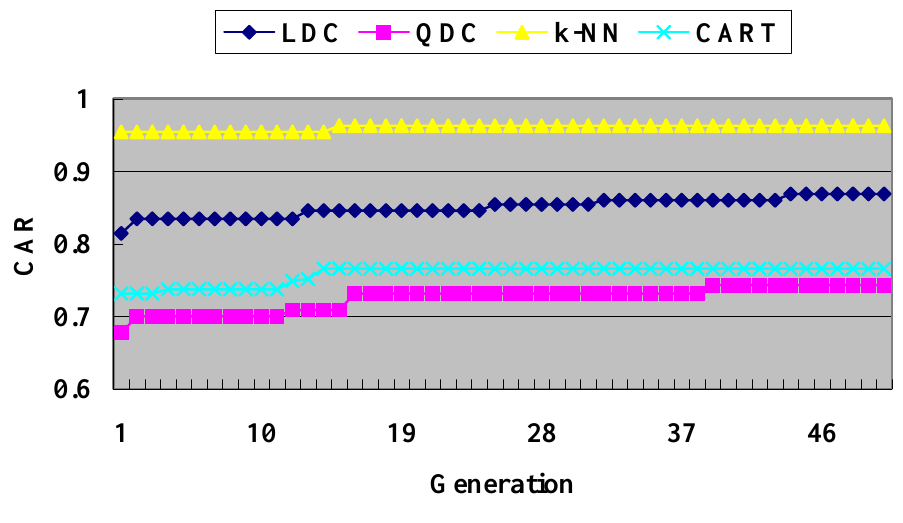
Figure 12. The best fitness curve versus